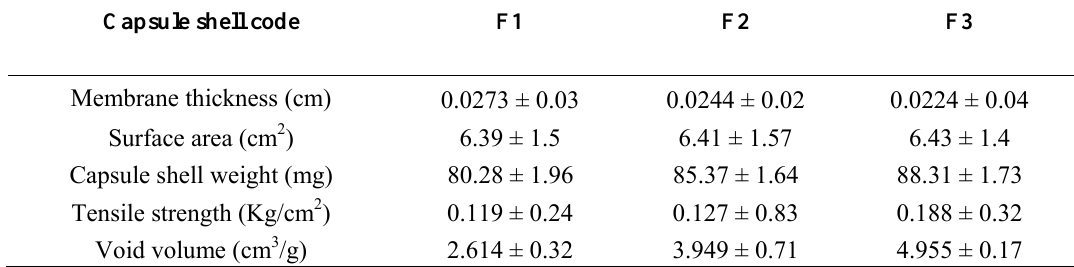
Table 3. Average physical characteristics of the asymmetric membrane